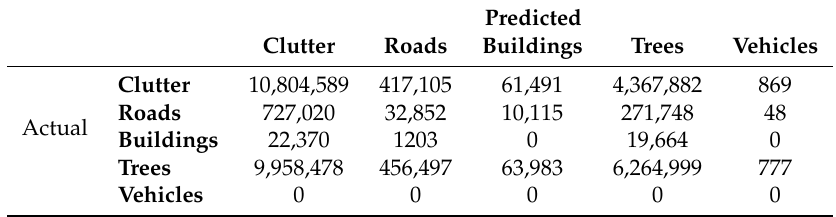
Table A6. Confusion matrix for the GSCNN model that is trained on coordinates and colors, and uses class weights, after 50 epochs.